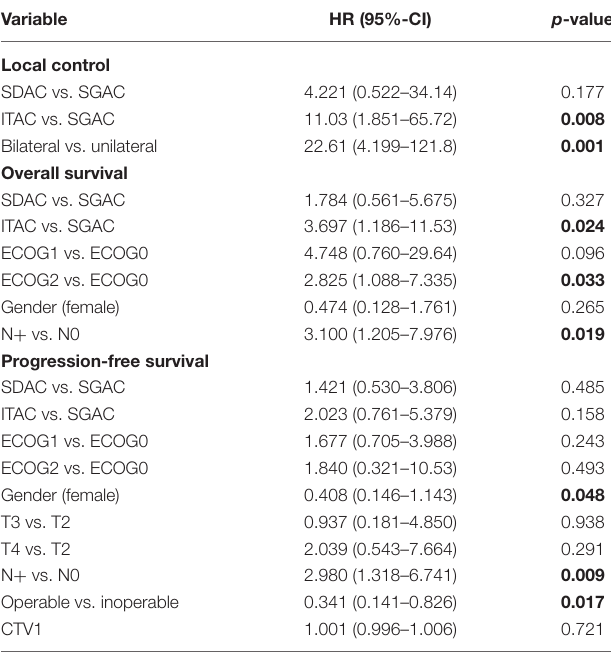
TABLE 3 | Multivariate analysis for LC, OS, and PFS.